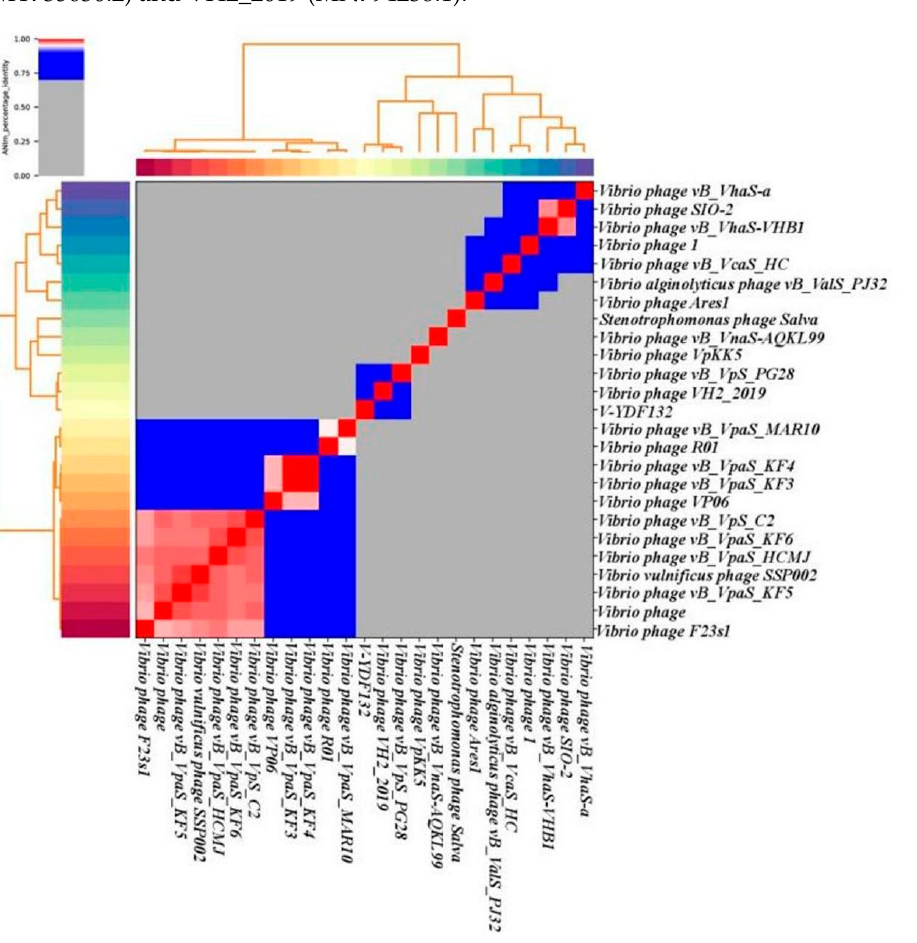
Figure 6. Heatmap of the average nucleotide identity (ANI) values for 25 whole genomes, sequenced from the related phages of the Siphoviridae family in the NCBI database, including phage V-YDF132. Values range from 0 (0%) ANI to 1 (100% ANI): gray represents 0% ANI; clusters of highly similar phages are highlighted in pink and